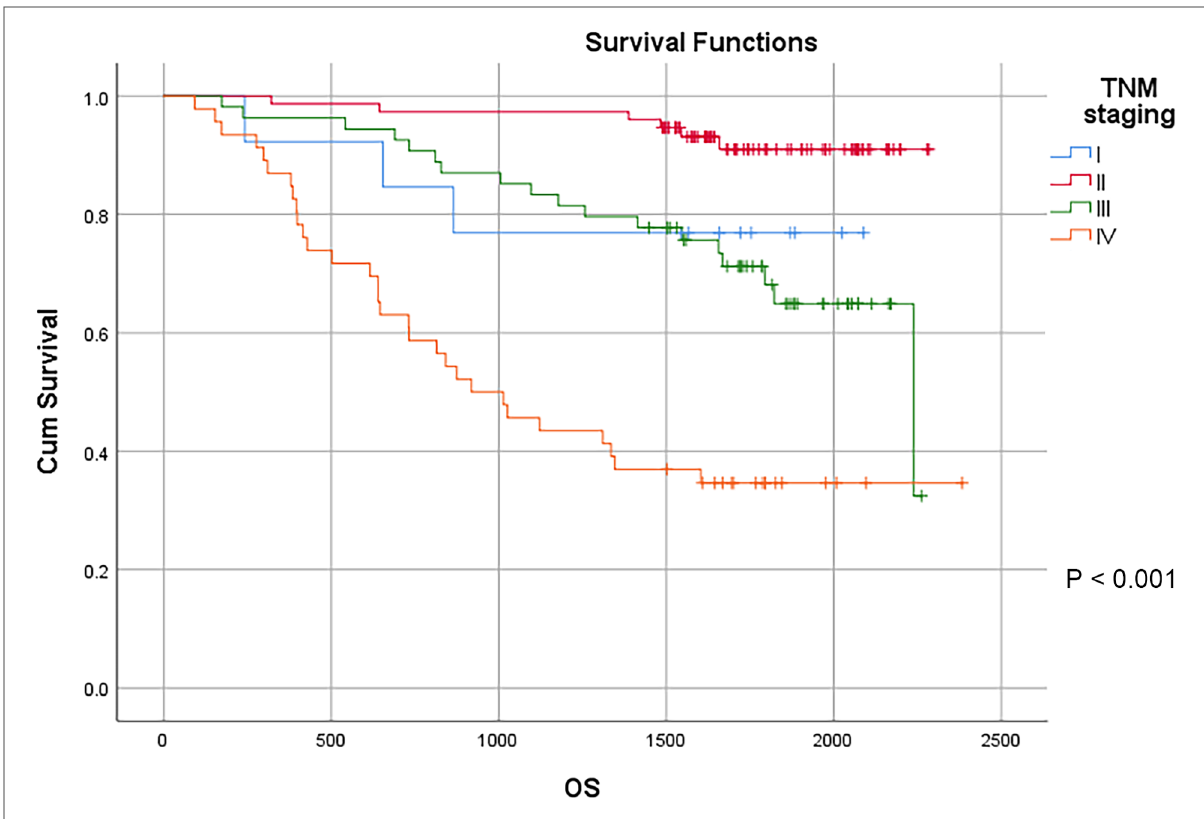
FIGURE 6 Survival curves of colon cancer patients in different TNM staging